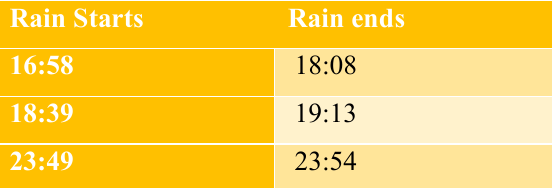
Table 1 Rain episodes on March 1 st , 2018 at NASA GSFC permanent observational